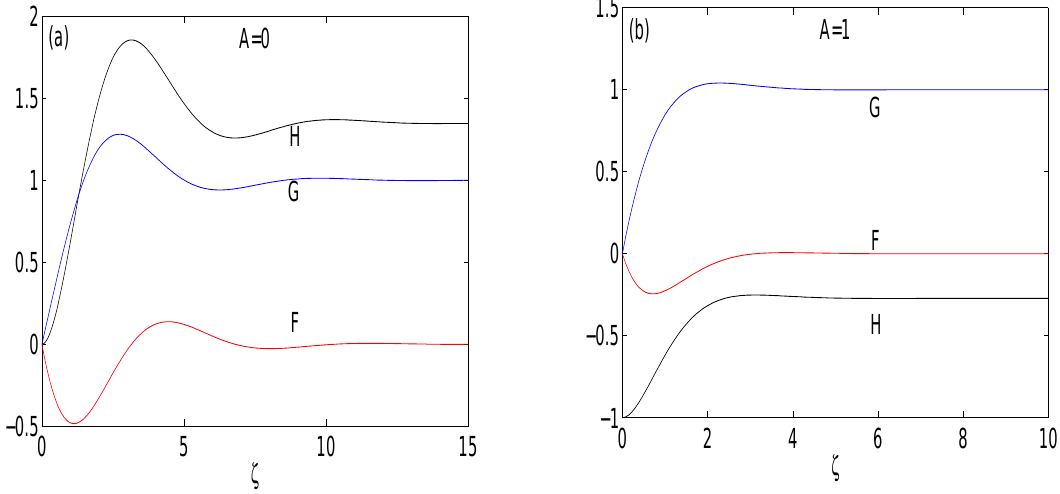
Figure 1. Velocity components ( 𝐻, 𝐹, and 𝐺 ) with and without suction effects.